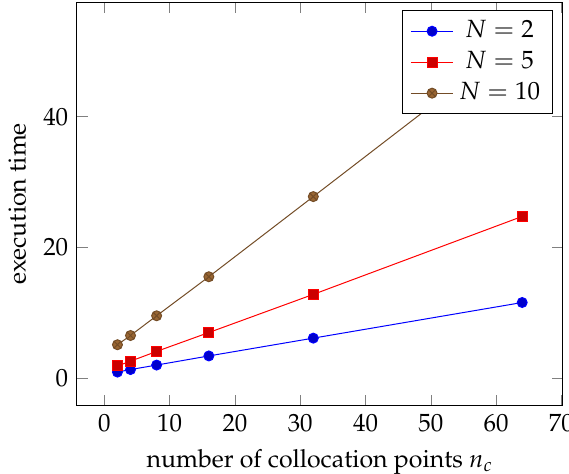
Figure 6. Normalized execution as a function of n c for a fixed number of terms in the Laurent expansion N = 2, N = 5, or N =